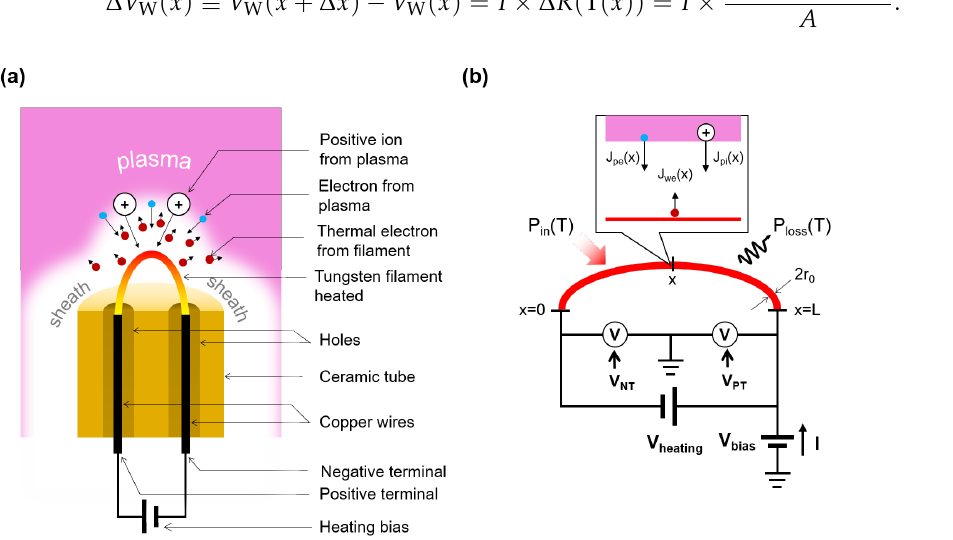
Figure 1. Schematic diagrams of ( a ) an emissive probe system using floating potential method and ( b ) a circuit model of the emissive